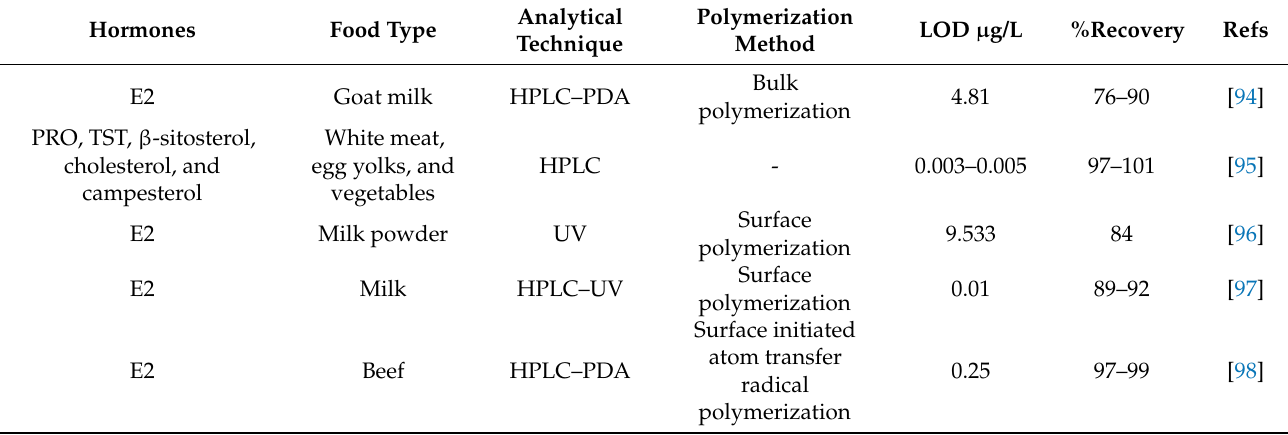
Table 3. Summary of application of MIPs for the determination of hormones in food